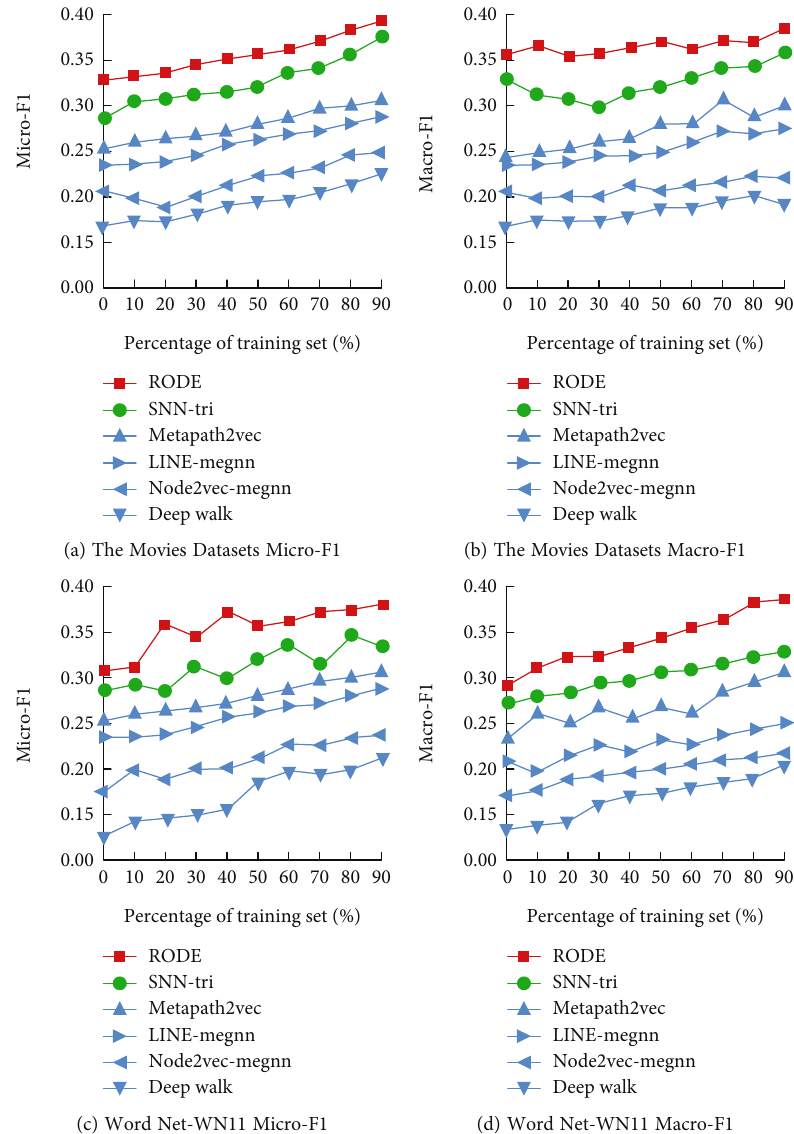
Figure 2: Multilabel node classi fi